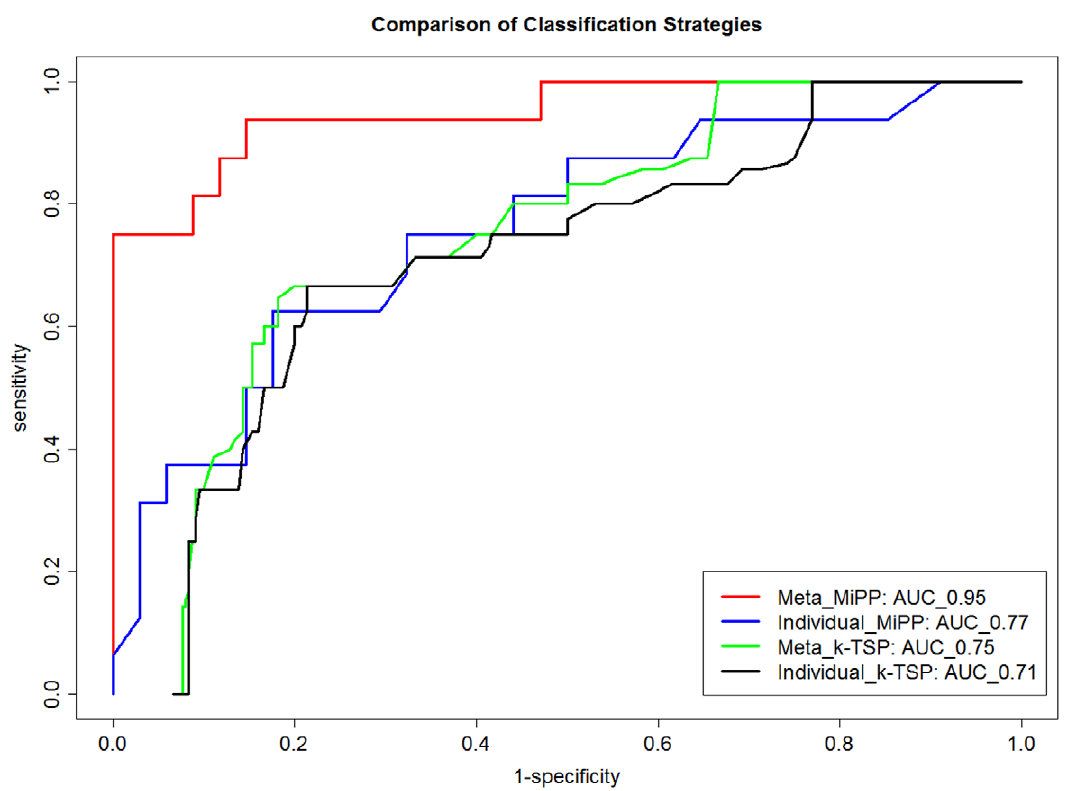
Figure 5. Comparison of classification strategies. The receiver operating characteristic (ROC) of PGF and GOOD samples using four classification strategies: (a) Meta_MiPP : Starting from the 690 significant probesets (FDR , =0.1) selected by meta-analysis we proposed in the study. An optimal 15_gene list from the 690 probesets was selected from MiPP classifier. ROC curve is drawn based on the five-fold cross-validation of the 50 human donor lung samples (GSE8021, Table 7 ) using the 15-gene prediction model. (b) Individual_MiPP : Top 690 probesets were selected from one-hit model in an individual study (GSE2411, Table 2 ) based on effect size. The reason for selecting this study is that it has the largest sample size. The performance of the MiPP classifier built on 25-genes optimally chosen from the 690 gene list in the single study is evaluated by ROC using five-fold cross-validation. (3) Meta_k-TSP : Starting from the 690 significant probesets selected by meta-analysis, then an optimal 9_gene pairs from the 690 probesets was selected from k-TSP classifier. The k (k=9) and ROC curve are based on the five-fold cross-validation. (4) Individual_k-TSP : Top 690 probesets were selected from one-hit model in an individual study (GSE2411, Table 2 ). An optimal 1_gene pairs from the 690 probesets was selected from k-TSP classifier. The k (k=1) and ROC curve are based on the five-fold